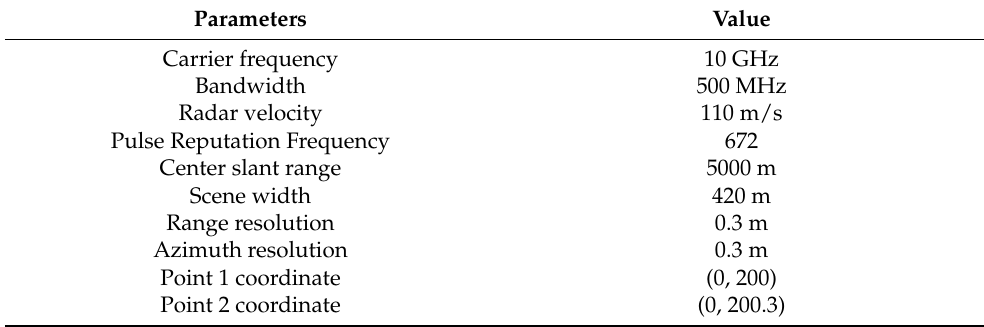
Table 1. Parameters of simulated SAR